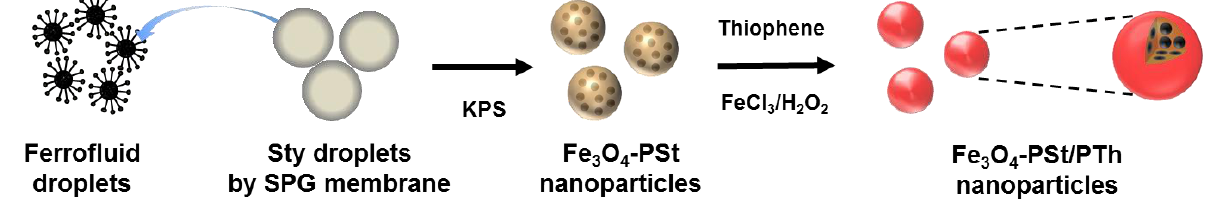
O -PSt/PTh) core/shell nanoparticles. 3 4